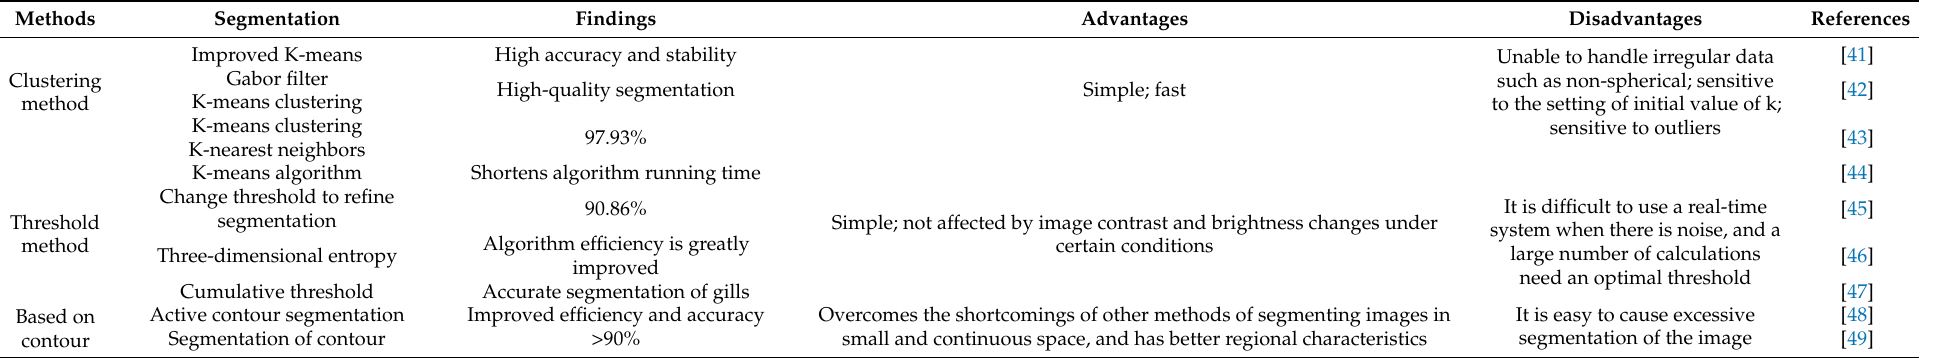
Table 1. The application of the clustering method, threshold method, and contour segmentation on aquatic environment.